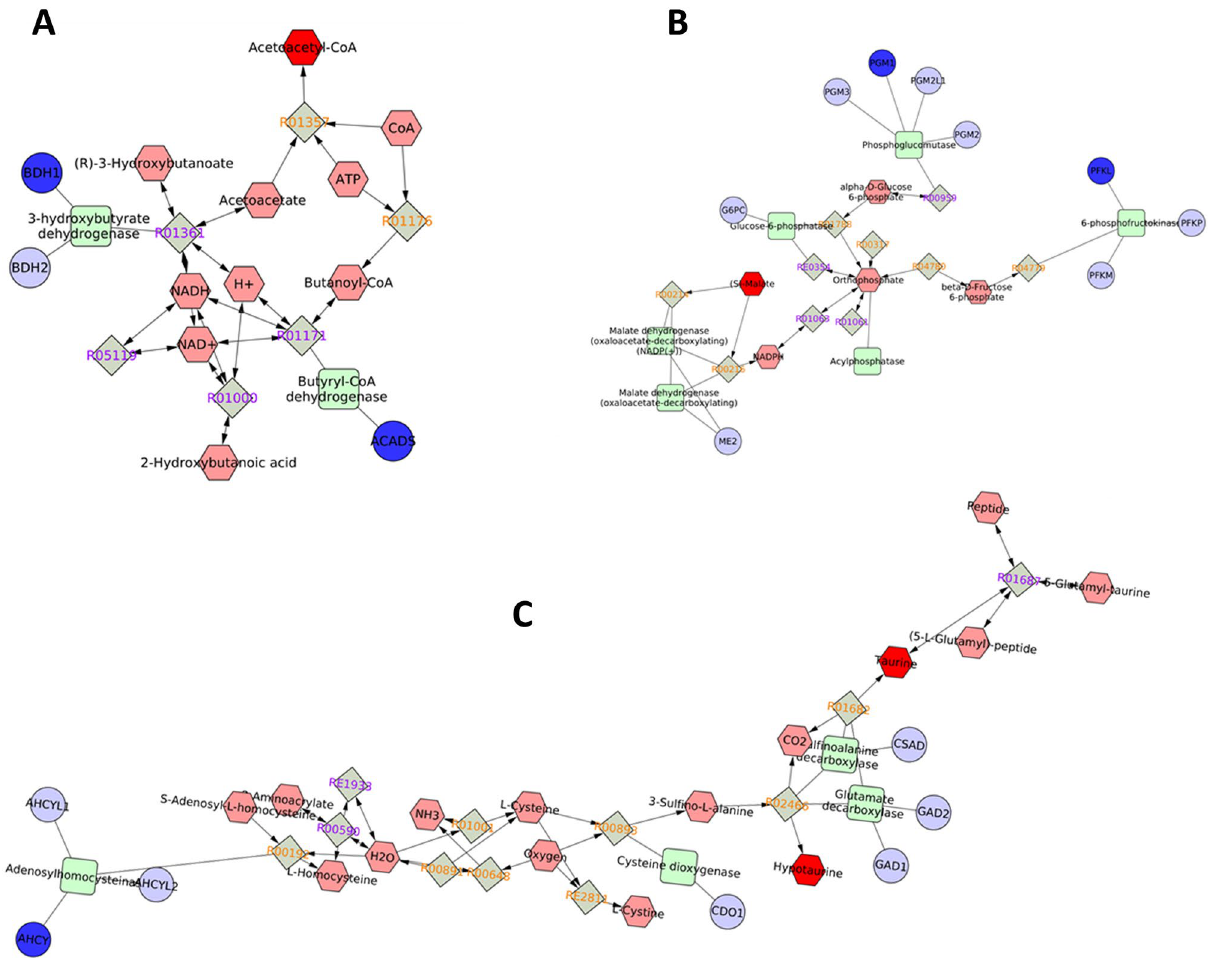
Figure 7. Integrated network of dysregulated transcripts, proteins and metabolites in low-fertility bulls. ( A ) Butanoate metabolism. ( B ) Glycolysis and gluconeogenesis metabolism. ( C ) Methionine and cysteine metabolism.